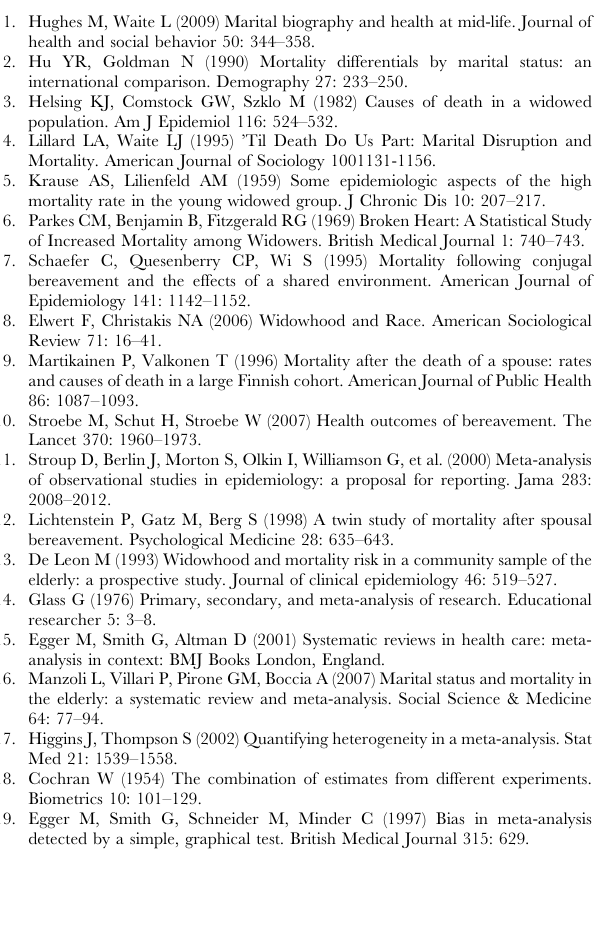
Table S3 Summary of Selected Studies on Mortality of